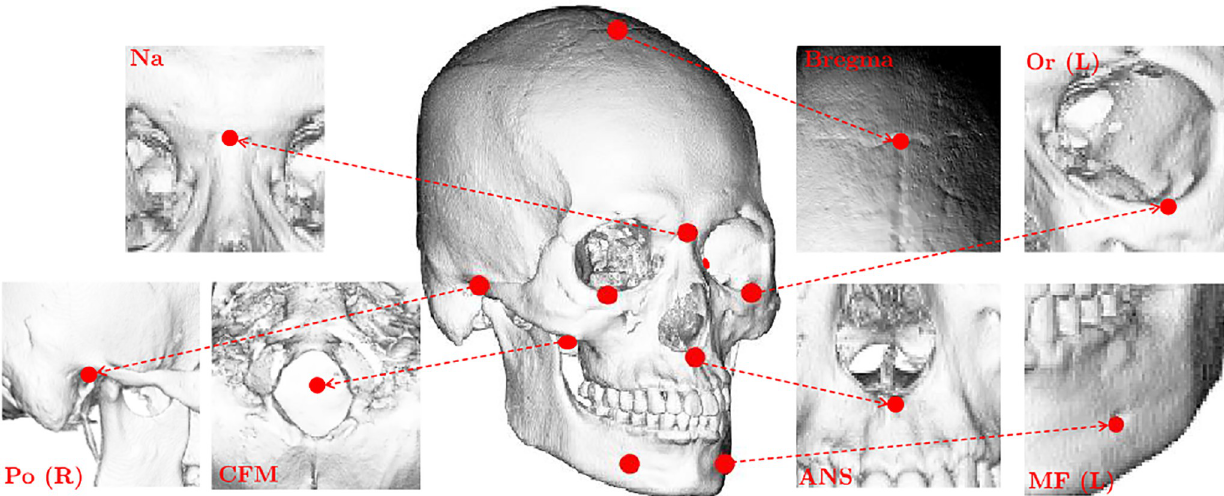
Fig 1. Reference landmarks. These are easy-to-find through CNN with input of the illuminated images because they have strong geometric cues that can be revealed in illuminated 2D images.